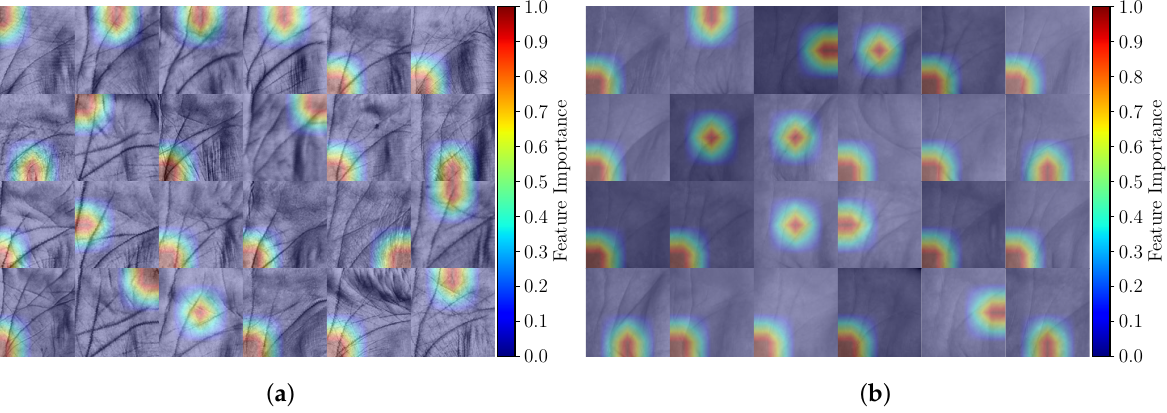
Figure 15. Exploring the feature importance learned from the attention mechanism for the: ( a ) IITD dataset and ( b ) CASIA dataset.